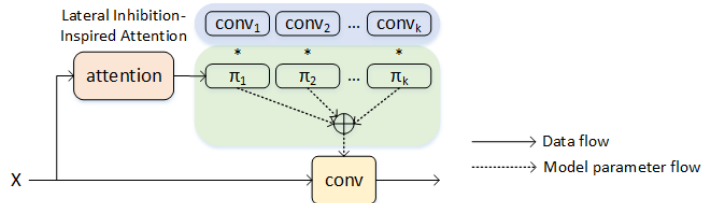
Figure 6. Lateral inhibition-inspired dynamic convolution.